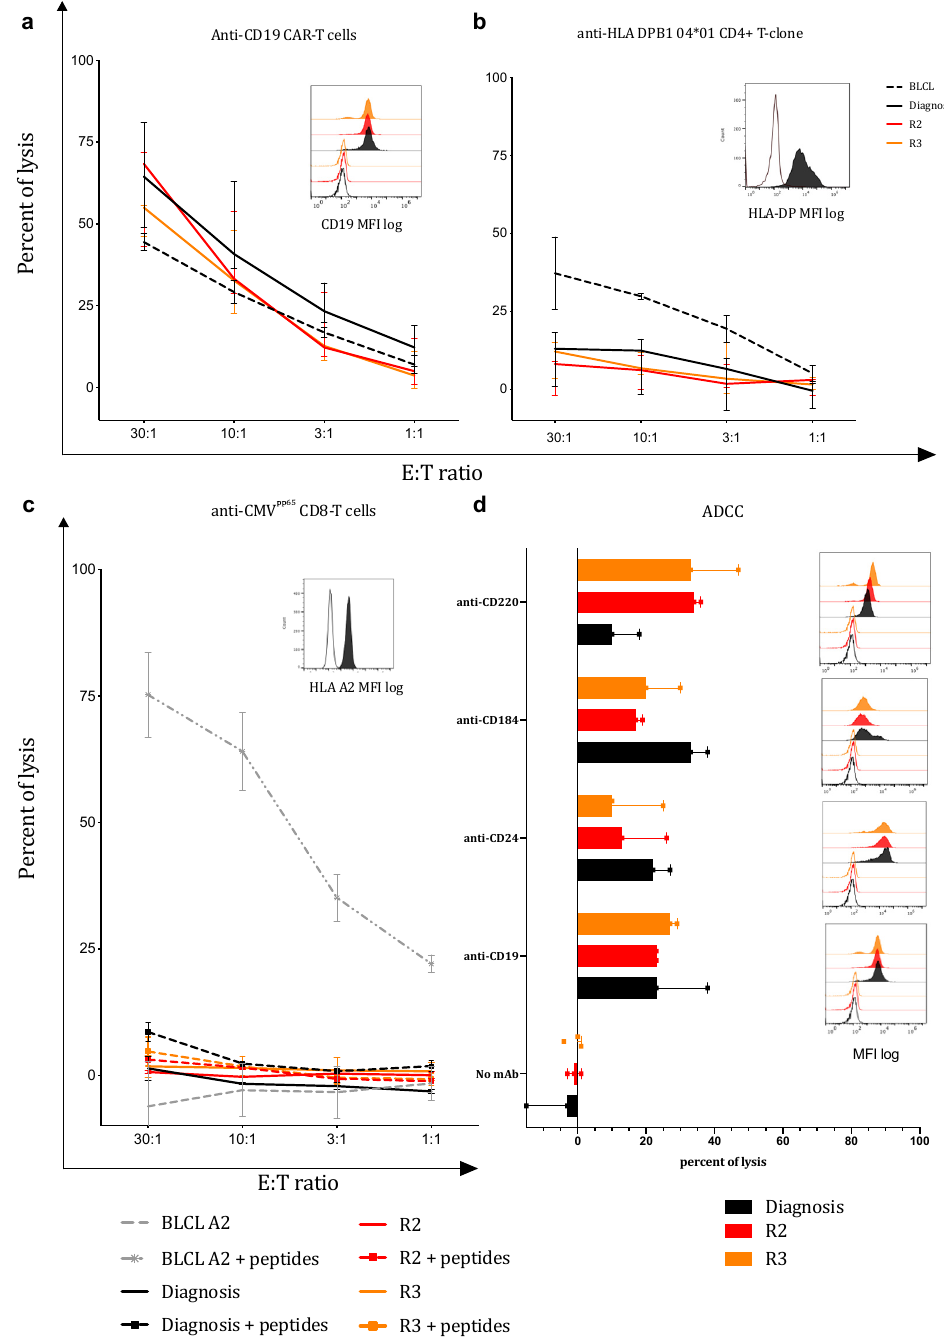
Figure 2. 4h- 51 Cr cytotoxic assays over 4 h. Percentage of ALL lysis at four E:T ratio after co-culture with the autologous anti-CD19 CAR-T cell preparation ( a ); or anti-HLA DPB1*04:01 CD4+ T-clone ( b ); or anti-CMVpp65 CD8 T-cells ( c ); or through the ADCC pathway using anti-CD220, anti-CD184, anti-CD24, and anti-CD19 antibodies in combination with mCD16-T lymphocytes ( d ). Expressions of targeted antigens are, respectively, represented as median of immunofluorescence (MFI) in a log of 10. (BLCL: B cell lineage used as controls). Three experiments in triplicate were performed. Results are given as median/error.